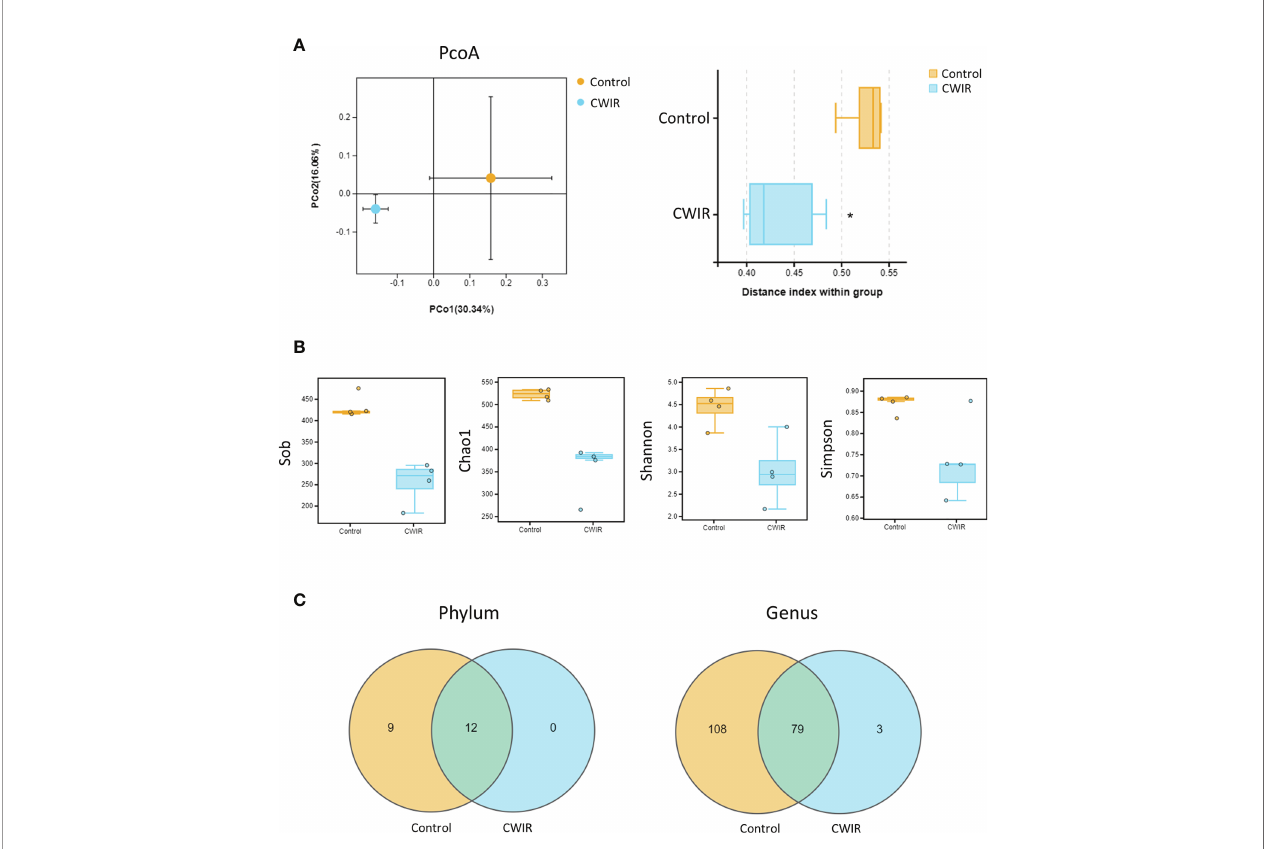
FIGURE 4 | Effect of CWIR on the gut microbiota in mice. (A) Principal coordinate plot (PCoA) of the unweighted unifrac distance at the Operational Taxonomic Units (OTU) level. Signi fi cance between groups was analyzed by Welch ’ s t-test. The PCoA plot revealed an obvious separation between the two groups (Adonis: P = 0.021). (B) The alpha diversity indexes revealed signi fi cantly decreased ecological diversity in the fecal microbiome in CWIR mice compared with control mice. (C) Effects of CWIR on the number of intestinal mucosa bacterial OTUs. The Venn diagram represents the number of shared and unique OTUs for the two groups at the phylum and genus levels (through Omicsmart online platform). n = 4 per group. * P < 0.05 vs .